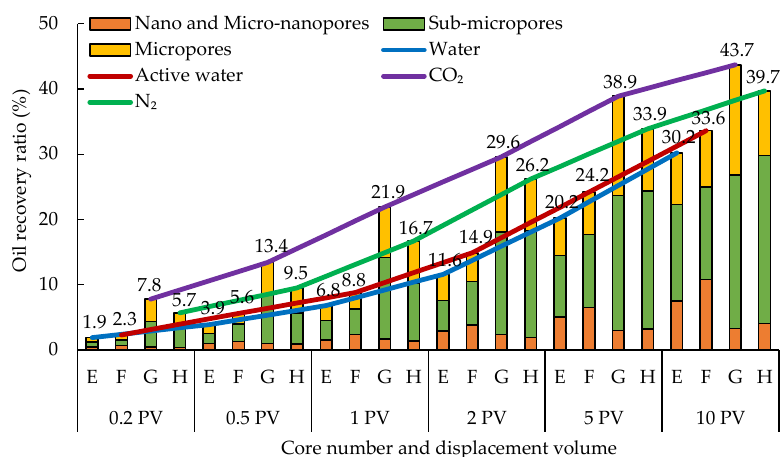
Figure 6. Oil recovery ratio of four cores and their different pores under different injection media. Energies 2018 , 11 , x FOR PEER REVIEW